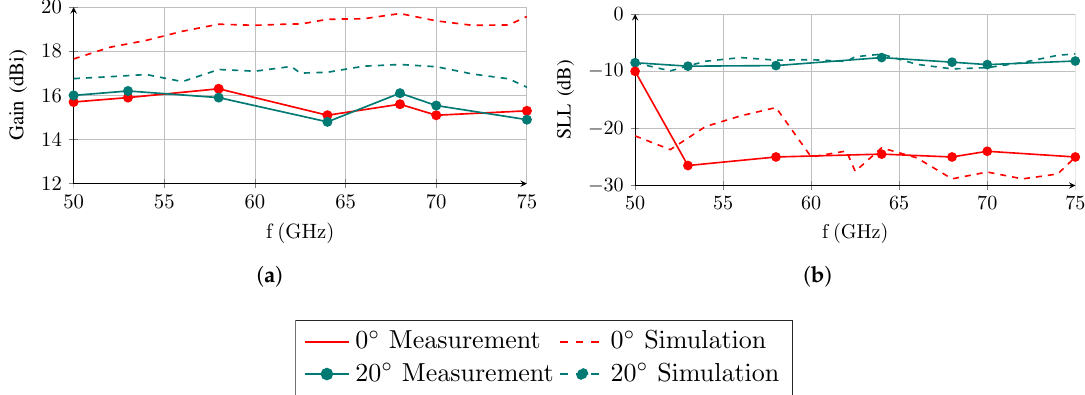
Figure 51. Comparison of simulated and measured ( a ) gain and ( b ) SLL behavior for θ beam = 0° and θ beam =